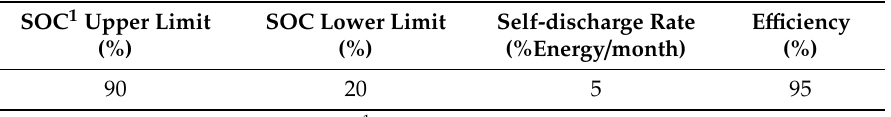
Table 1. Energy storage systems (ESS)